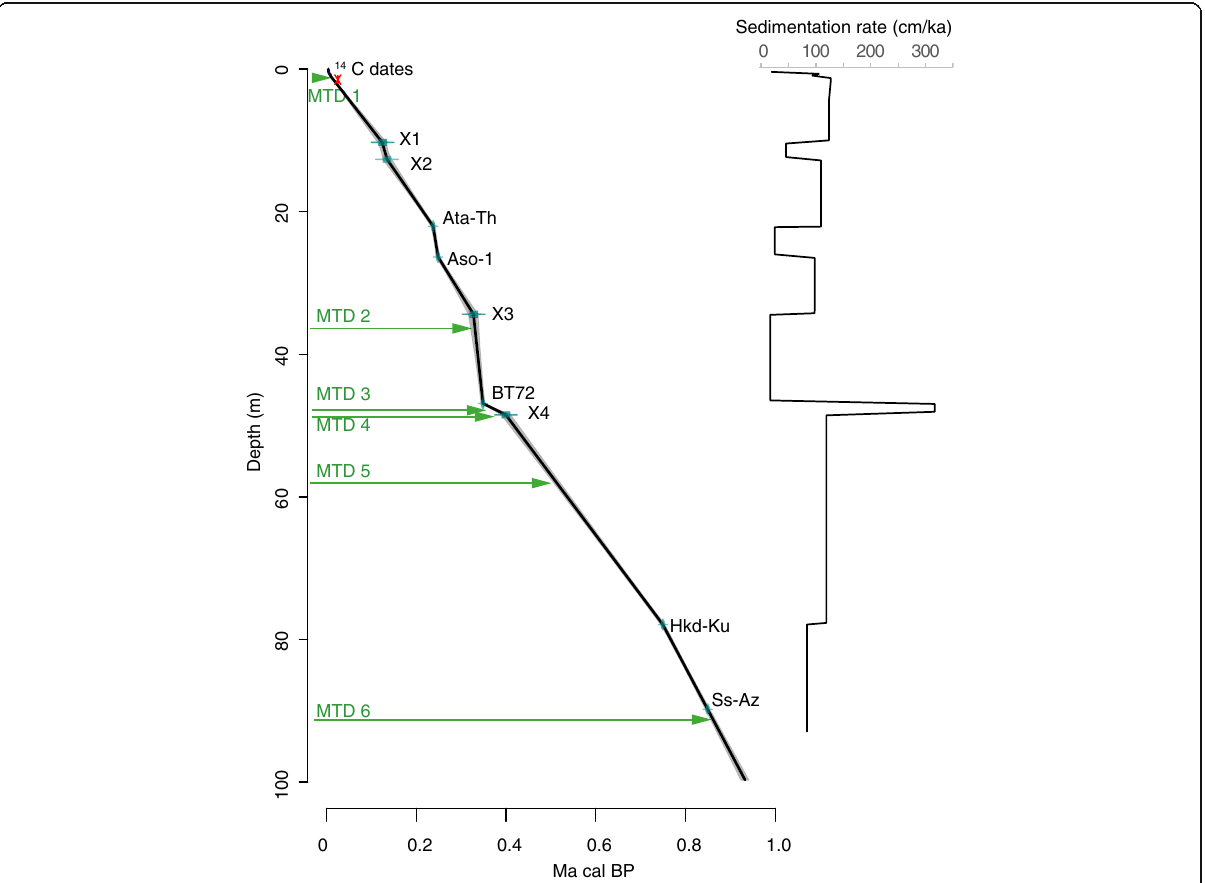
Fig. 8 Age – depth model and profile of sedimentation rates at C0018A based on 14 C dates from the top of the drill core, tephrochronology, and matching points (X1 – X4) used for correlation of the δ 18 O values of C0018A and the stack reference curve LR04. The depth of the MTD is also shown